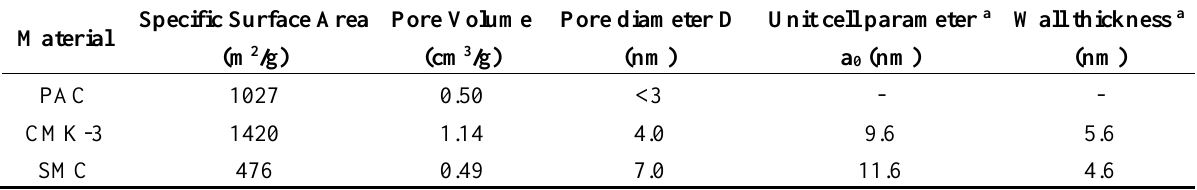
Figure 1. Nitrogen sorption isotherms ( a ) and their corresponding pore size distributions obtained by density functional theory (DFT) method ( b ) of CMK-3 (■), PAC (●) and SMC (▲). Table 1. Structural properties of the